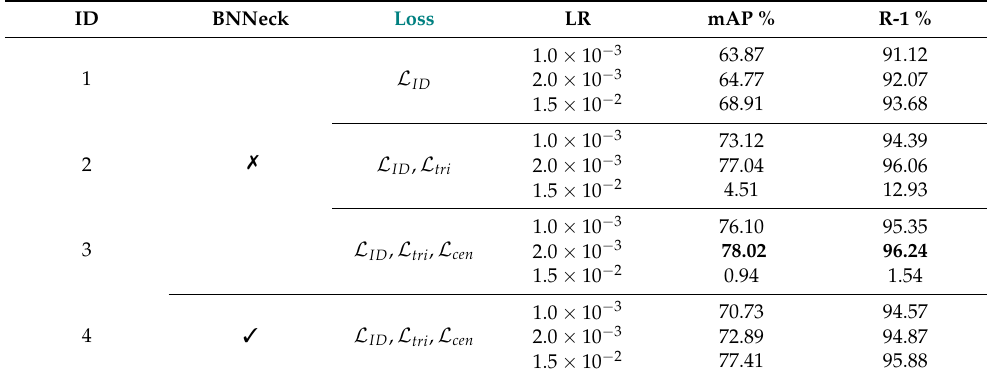
Table 8. Performance of the models using different loss functions and the same learning